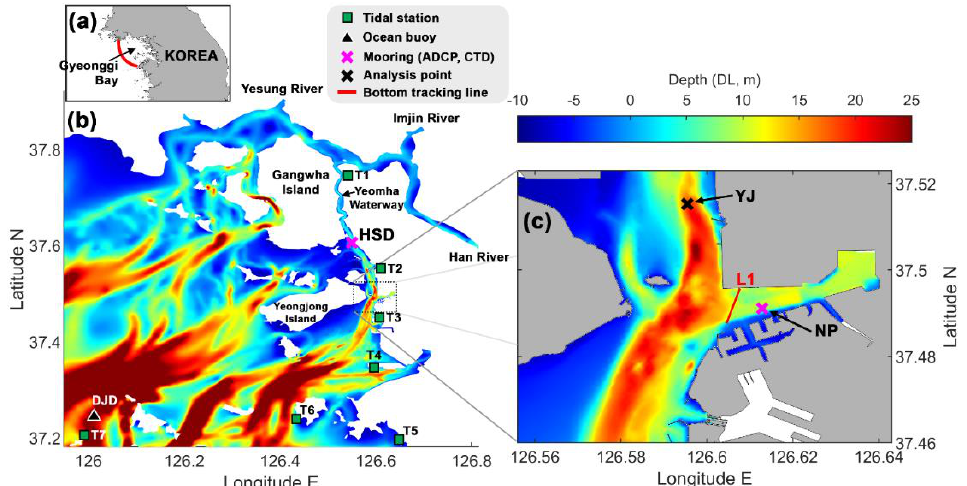
Figure 1. ( a ) Part of the Korean Peninsula; ( b ) Gyeonggi Bay and observation sites; ( c ) the North Port and its bathymetry. HSD (Hwangsan-Do) and NP (North Port) indicate locations of acoustic doppler current profiler (ADCP) observation. DJD (Deokjeok-Do) indicates an ocean buoy observation site.